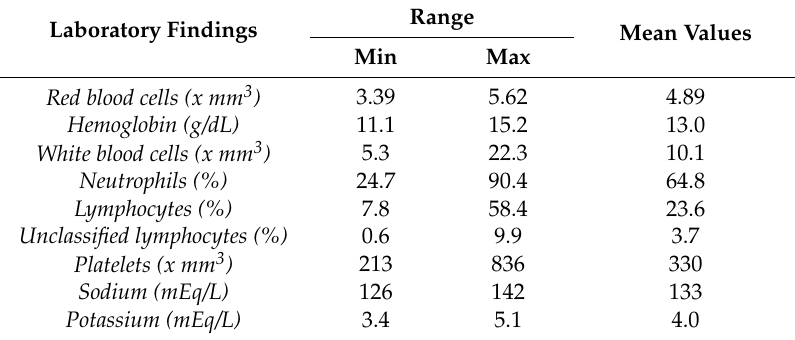
Table 2. Laboratory findings in 44 hospitalized children with Salmonella enterica Typhimurium infection, on